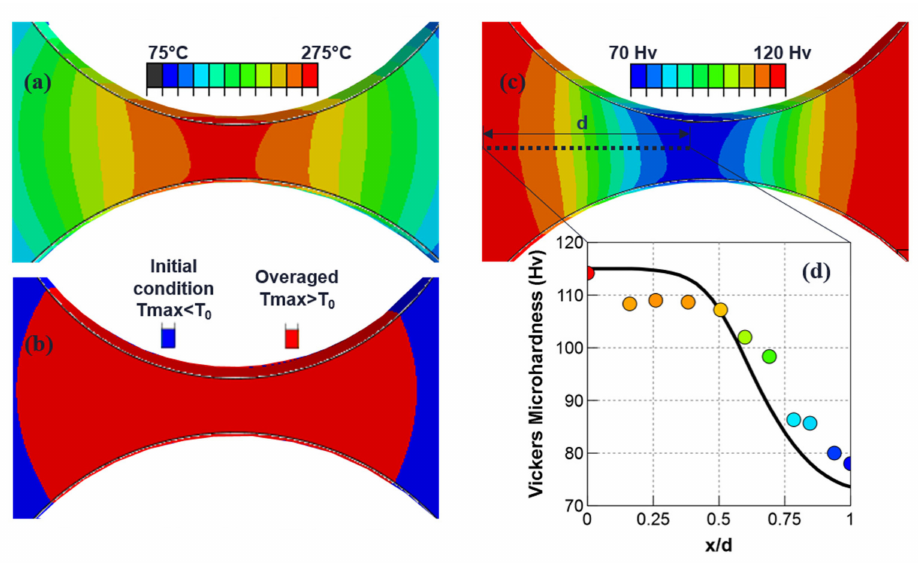
Figure 7. Alloy AlSi7Cu0.5Mg0.3-T7. Detail analysis of aging of a simplified structure of cylinder head submitted to a full thermal load ( a ) thermal map in the inter-valve bridge. ( b ) Temperature areas and aging conditions considered in historical design protocol. The blue area corresponds to low temperature area where initial aging conditions is used, the red one to high temperature area where an asymptotic over-aging conditions is used. ( c ) Microhardness gradient predicted in inter-valve bridge after 10,000 thermal cycles. ( d ) Comparison between experiment (symbols) and simulated (solid curve) microhardness gradient along a half of the inter-valve bridge. The location of microhardness analysis is presented in ( c